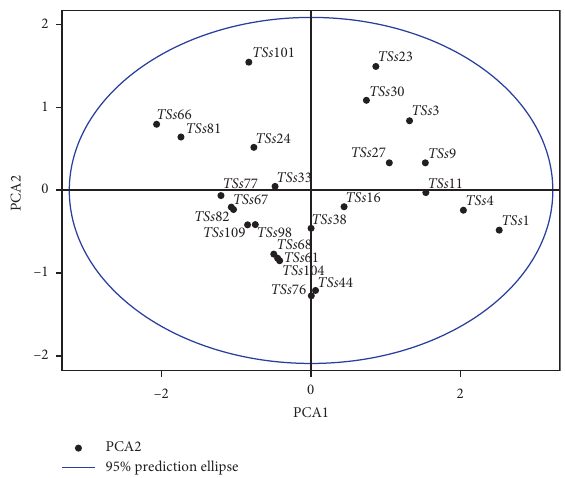
Figure 4: Multivariate analysis based on antinutrient contents of unprocessed samples. PCA: principal component axis; TSs: Tropical Sphenostylis stenocarpa .